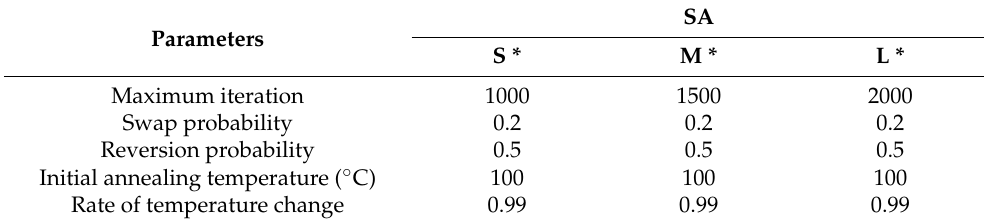
Table 2. Parameter setting for SA.